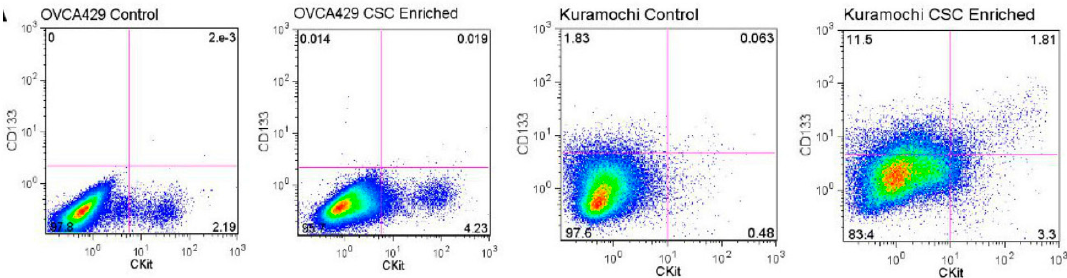
Figure 5. Flow cytometry for the stem cell markers CD117 and CD133 on ovarian cancer cells before and after CSC enrichment. Untreated OVCA429 and Kuramochi cells or cells enriched for CSCs (by treatment with cisplatin and paclitaxel followed by culturing CSCs in stem cell media on ultra low adhesion plates) [56] were stained for stem cell markers CD117 (cKIT is the gene that encodes CD117) (X-axis) and CD133 (Y-axis).